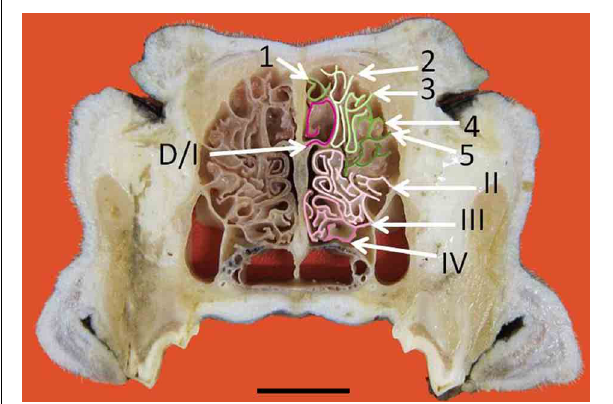
FIGURE 3 | Transverse frozen section of the nasal cavity. D, dorsal nasal concha. Ectoturbinates are identified by Arabic numerals (1–5) and endoturbinates by roman numerals (I–IV). Scale bar: 2cm (see Figure S3).